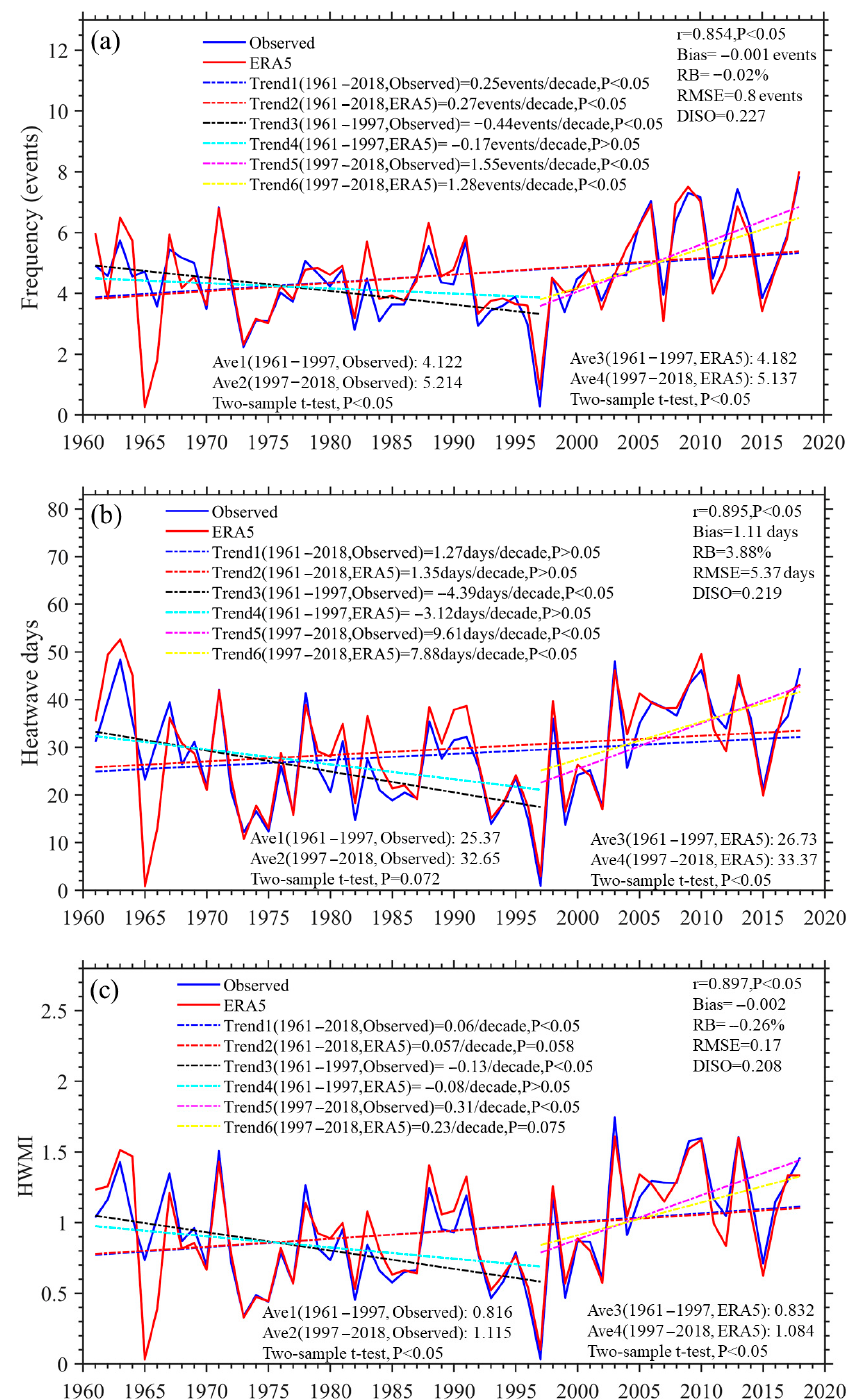
Figure 4. Temporal variations of ( a ) heatwave frequency, ( b ) heatwave days, and ( c ) HWMI per-year averaged GRB from 1961 to 2018.